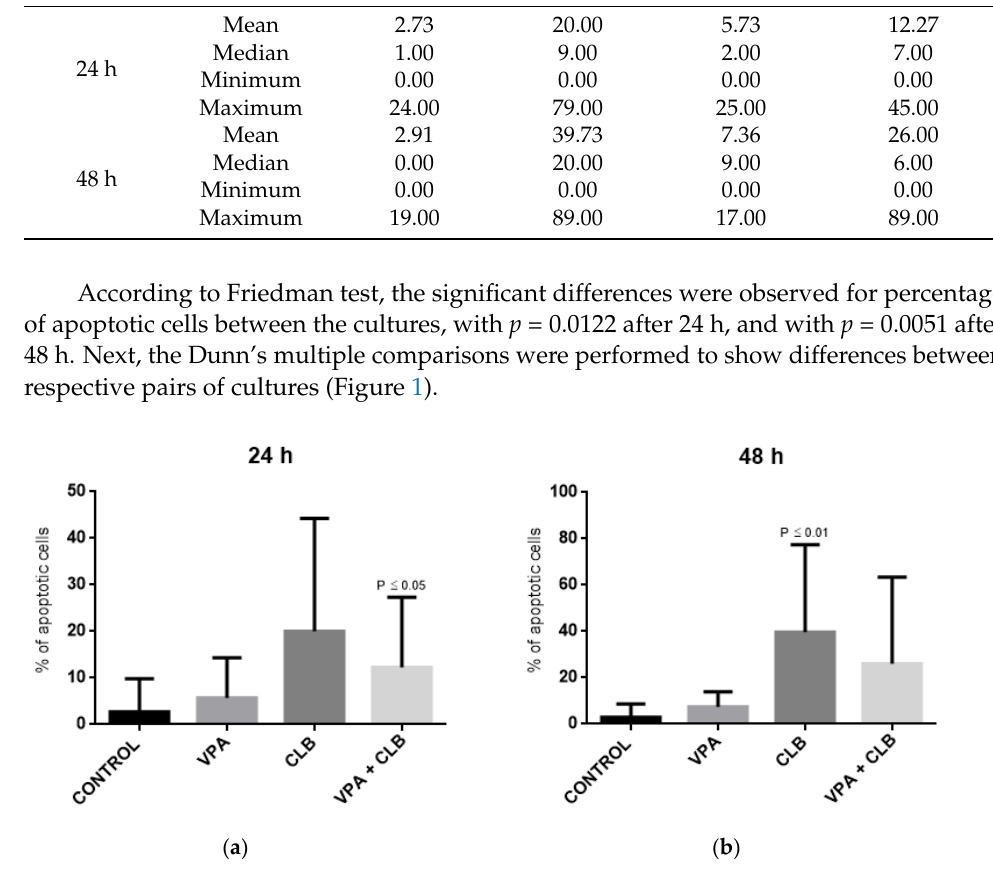
Figure 1. Apoptosis induced by CLB and VPA in CLL cells ( n = 17). The graphs show percentage of apoptotic cells in experimental cell cultures after 24 h of incubation ( a ) and after 48 h of incubation ( b ). p values indicate significant differences versus control groups.